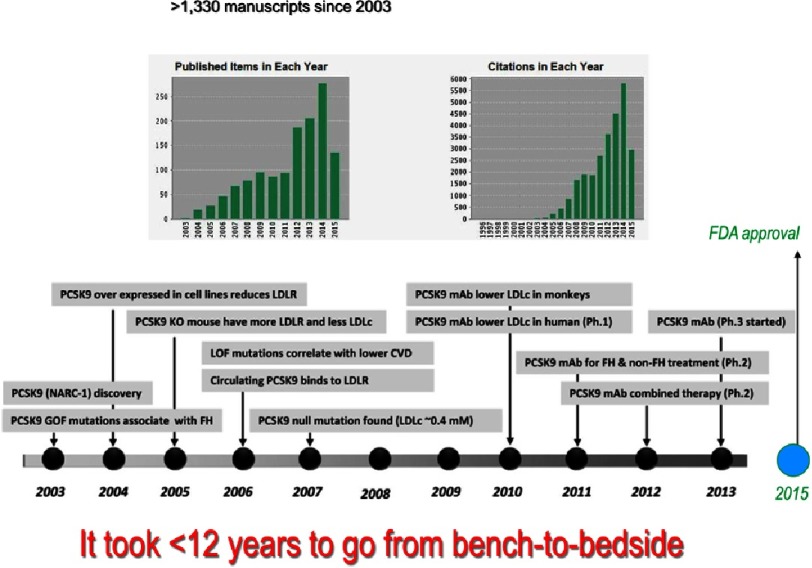
Proprotein convertase subtilisin kexin 9 (PCSK9): historical perspective from its discovery to clinical applications and the manuscripts associated with PCSK9 since 2003.The pace of research, from PCSK9 discovery through to clinical trials, has been rapid starting from its discovery in 2003 and the proof-of-principle that mAbs can inhibit its function in 2010, all the way to ongoing phase III clinical trials and the final approval by the FDA in 2015. CVD indicates cardiovascular disease; FH, familial hypercholesterolemia; GOF, gain-of-function; KO, knockout; LDL-C, low-density lipoprotein-cholesterol; LDLR, LDL receptor; LOF, loss-of-function. Notice that >1,330 manuscripts were published on the subject of PCSK9 since 2003, resulting in an H-index of 76.